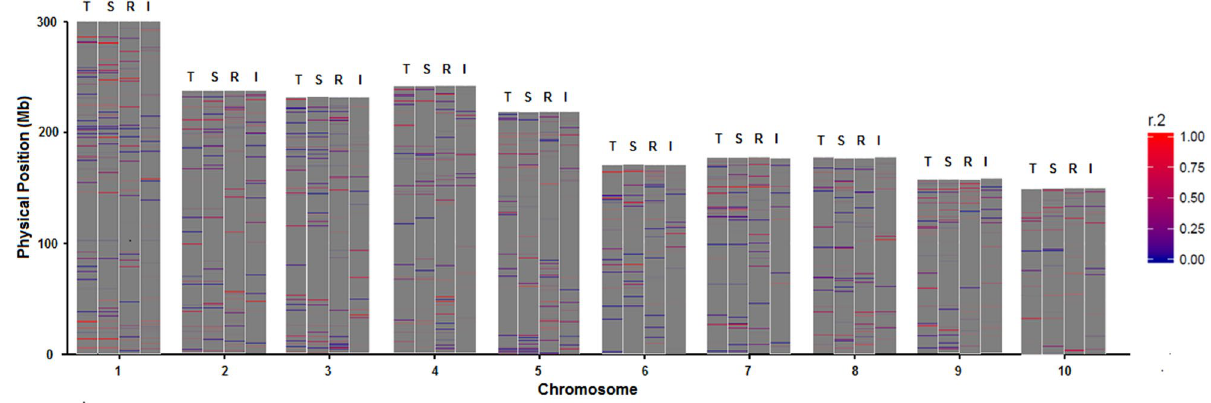
Figure 6. LD block pattern of four subgroups. TSPT (T), SS (S), M-Reid (R), and Iodent Genetic and breeding features of different heterotic groups. PCA plots at Fig. 4 and the Fst tree on